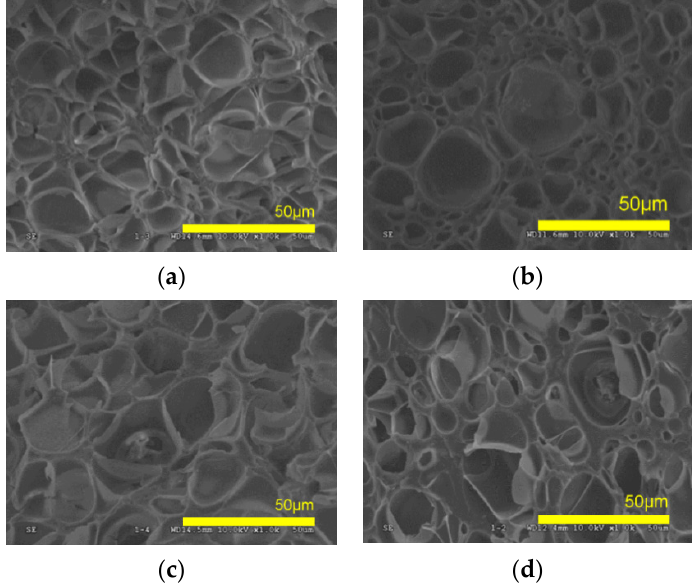
Figure 2. SEM microstructure of poly(methyl methacrylate) (PMMA)/20 wt% additive based foams in Set I ( a ) D200, ( b ) D480, ( c ) Dlab, ( d ) block copolymer MAM. Table 3. Set of experiments I: Characteristics of PMMA-based foams obtained after a one-step batch foaming at a saturation temperature of 80 °C, a saturation pressure of 31.5 MPa and at a gas depressurization speed of Δ P/dt~12 MPa·min − 1 .